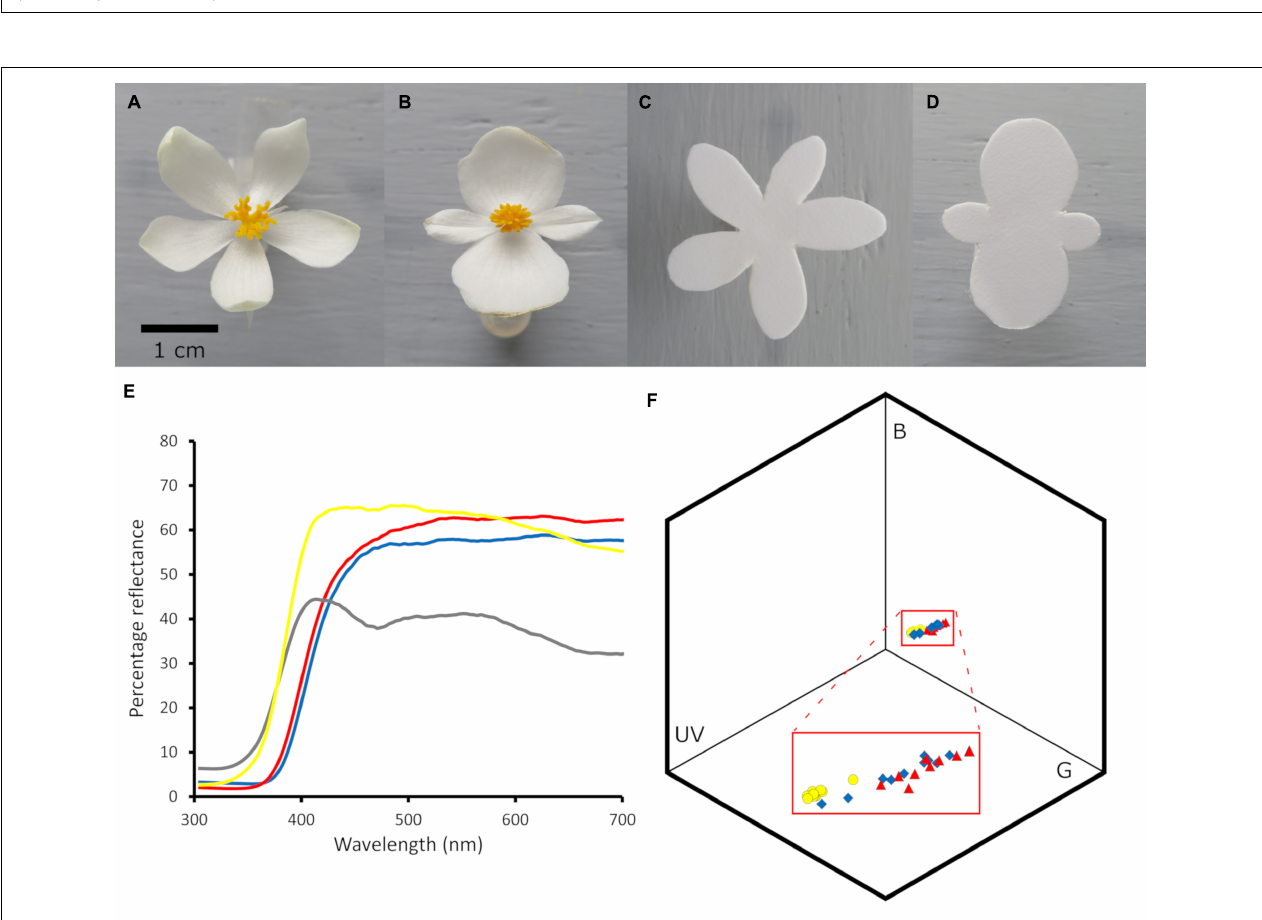
FIGURE 2 | Imperfect mimicry among female (mimics) and male (models) in Begonia odorata flowers. (A) Female and (B) male flowers and artificial corollas of (C) female and (D) male medium-sized flowers. (E) The mean reflectance spectra of the female (red line) and male (blue line) flowers, the artificial corolla (yellow line), and the arena background (grey line) against which flowers were displayed; spectra smoothed using a 100 point moving average in Microsoft Excel. (F) The loci in Bombus impatiens color space of male petals (blue diamonds), female petals (red triangles), and artificial corollas (yellow circles) against the test arena background: artificial corollas resemble the color of live flower corollas ( N = 10, 10, 10 male, female, and artificial flowers, respectively). On average, artificial petals and live petals differed from each other by 0.09 color units and from the background by 0.14 and 0.23 color units, respectively.